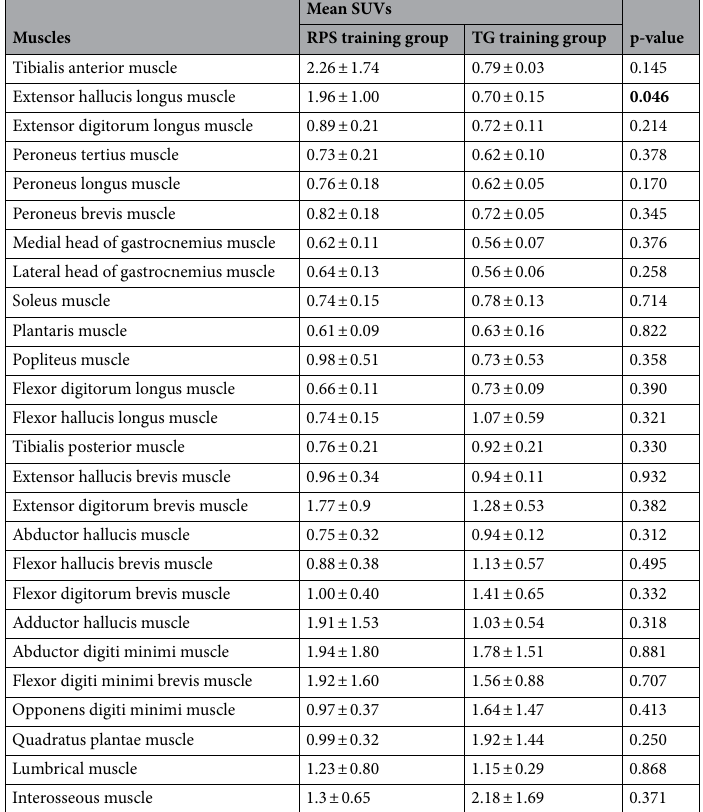
Table 5. Differences in mean SUVs between the RPS training and TG training groups. Values are presented as the mean ± standard deviation. RPS: rock-paper-scissors; TG: towel gathering; SUV: standardized uptake value. The paired-samples t-test was used to evaluate differences in the mean SUV between the RPS training and TG training groups. Statistical significance was set at P <